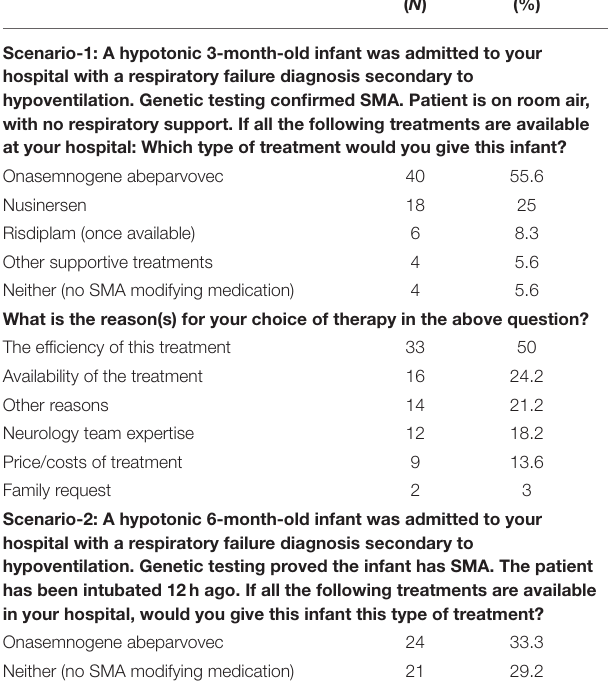
TABLE 3 | Knowledge and attitude toward gene therapy for SMA. Knowledge and attitude toward gene therapy for SMA